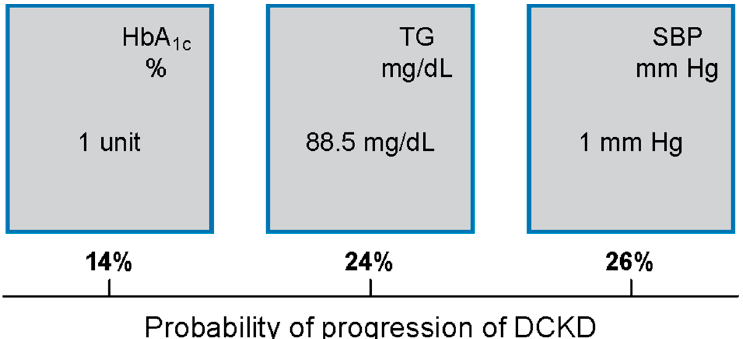
Figure 2. An increase of HbA 1c by 1 unit, triglycerides (TG) by 88.5 mg/dL, and systolic blood pressure (SBP) by 1 mm Hg, increased the progression of diabetic chronic kidney disease (DCKD) by 14%, 24%, and 26%, respectively.